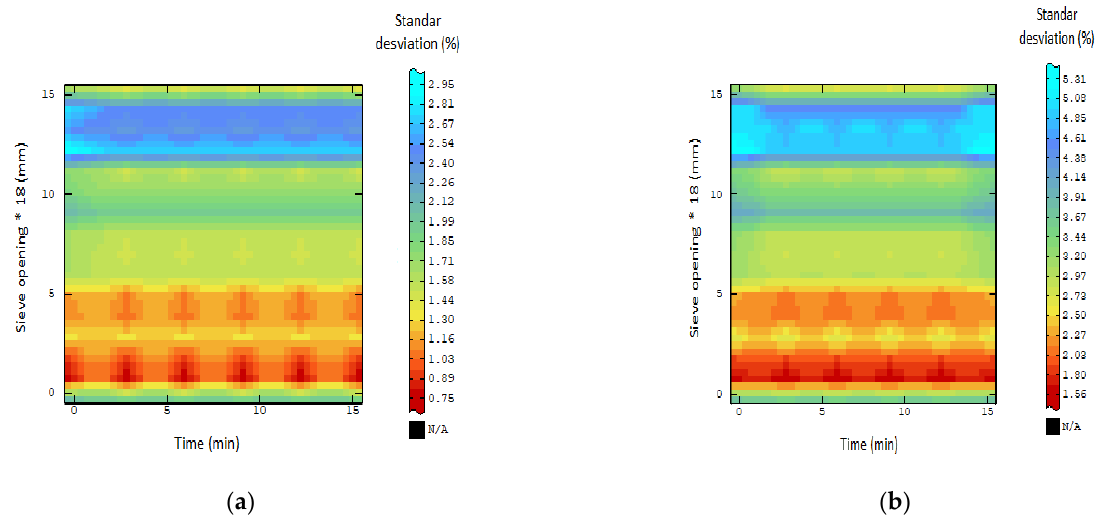
Figure 8. Cross-evaluation of the geostatistical analysis of LGP-1 with ore-B: (a) scatter plot (identity line) on the x-axis is the modeled data, and the y-axis shows the experimental data; (b) standardized error histogram; (c) standardized error based on the estimated value; and (d) histogram and its sta- tistical parameters of the estimated data.